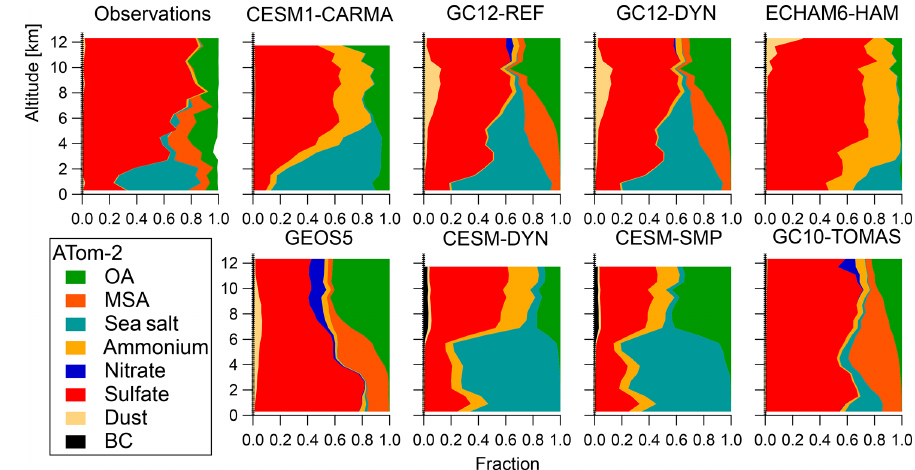
Figure 10. Comparison of the measured and predicted composition of submicron aerosols as a function of altitude over the remote Southern Ocean region during NH Winter (ATom-2). For models that do not calculate ammonium in the aerosol (such as CESM1-CARMA, CESM2- SMP, CESM2-DYN, and ECHAM6-HAM), ammonium was estimated from the sulfate mass assuming the formation of ammonium sulfate. Note that while the modeled and measured submicron sea salt size ranges agree fairly well (Table 1), this is not quite the case for dust. Given that the accumulation-mode dust in the models presented contains larger sizes than the AMS range ( < 500nm), it is expected that the modeled dust concentration will be larger than